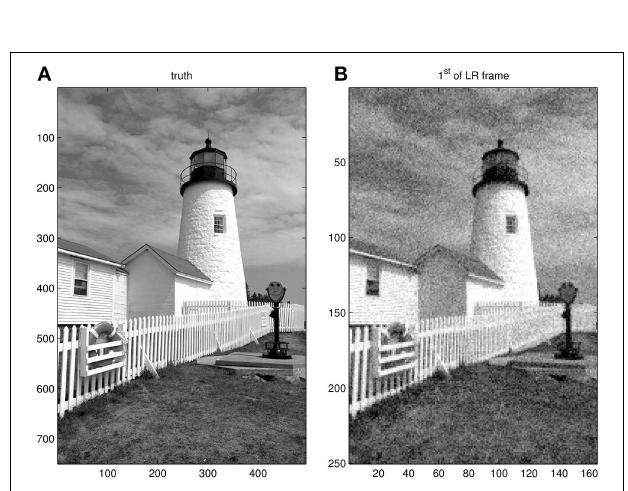
FIGURE 5 | Lighthouse image. (A) Truth image and (B) first simulated LR frame with L 3 and σ η 10 . = =